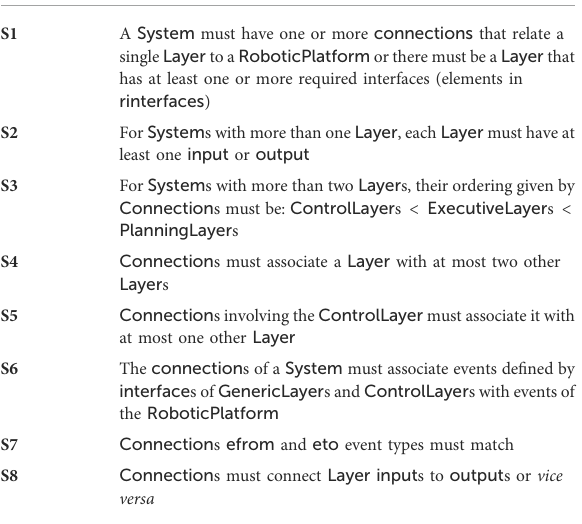
TABLE 2 The well-formedness conditions of RoboArch. Condition